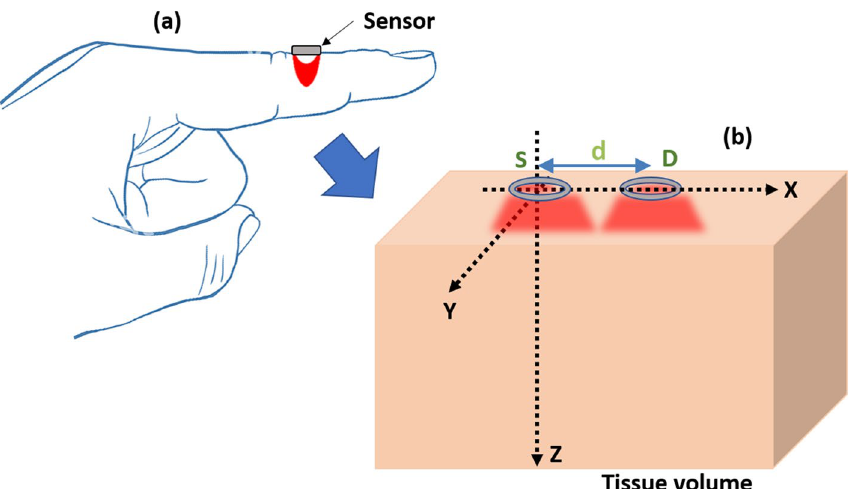
Figure 2. Schematic of the sensor-tissue interaction platform. The ROI, i.e., a volume of human finger tissue interrogated by the sensor, is presented in the 3D Cartesian co-ordinate (XYZ) where the optical source (S) and detector (D) are respectively placed at the origin, and a distance d from